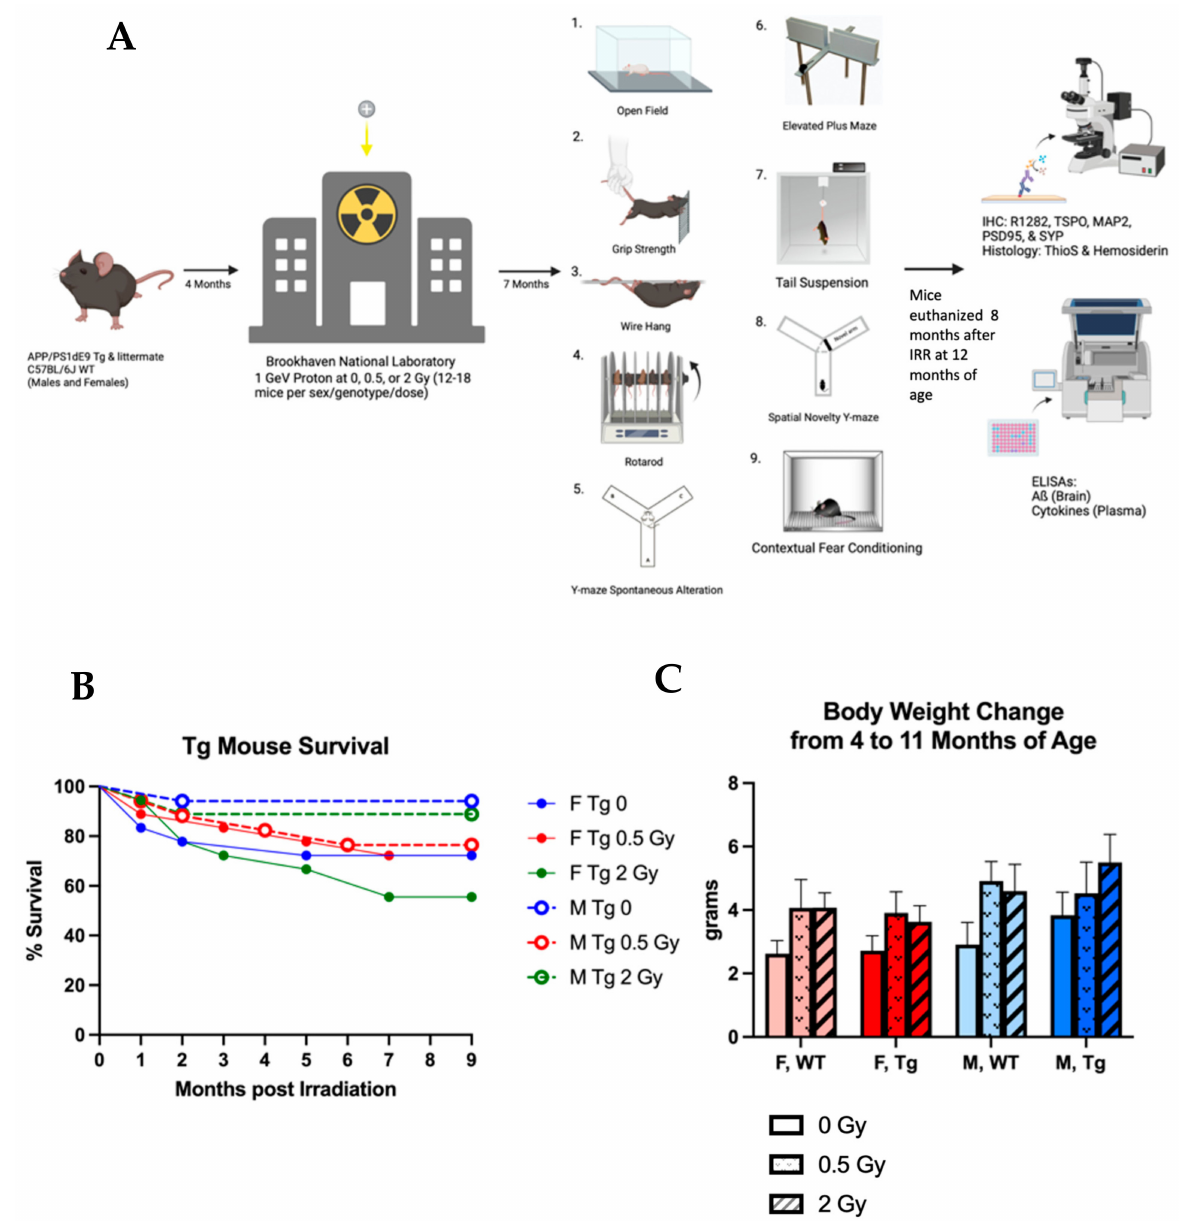
Figure 1. ( A ): Study timeline. APP/PS1 (Tg) and WT mice were transported to and from Brookhaven National Laboratory for irradiation at four months of age with 0, 0.5, or 2Gy of 1 GeV protons ( n = 12–18 mice/group). Mice underwent behavioral tests starting at seven months post-irradiation ( n = 7–8 mice/group). The mice were sacrificed and tissues harvested at 13 months of age (nine months post irradiation) for immunohistochemistry, histology, and ELISAs ( n = 6–16 mice/group). Created with BioRender.com ( B ): APP/PS1 mouse survival curve. No statistically significant radiation effects were observed by the log-rank test. ( C ): Change in bodyweight from 4 to 11 months of age. Proton irradiation had a significant main effect by 3-way ANOVA ( n = 10–16